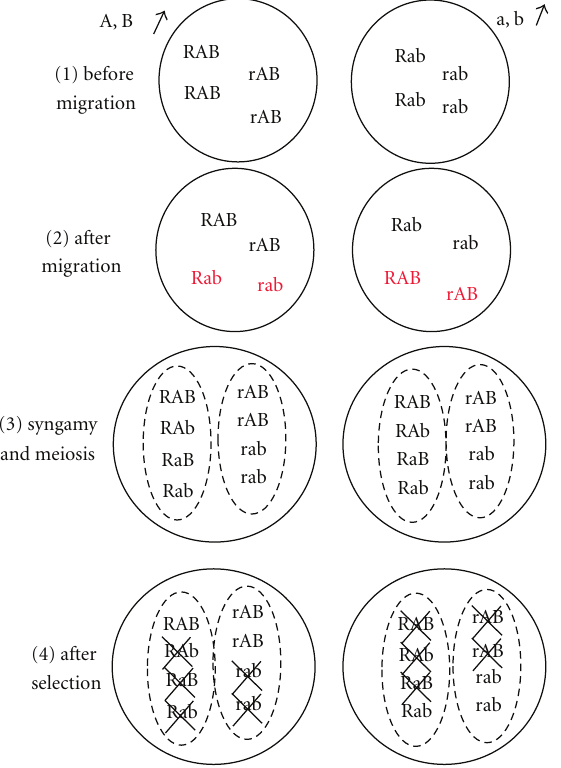
Figure 4: Indirect selection on a recombination modifier with local adaptation. Sketches how a recombination modifier evolves in presence of local adaptation (for the sake of illustration, the R allele causes maximal recombination, and the r allele specifies zero recombination). Before migration (step 1), consider two habitats with haploid individuals. On the left, the A and B alleles are favored at two di ff erent loci; the a and b alleles are favored on the right. To simplify the illustration, we consider the alleles to be fixed where they are beneficial. After migration between habitats (step (2) with m = 1/2, migrants shown in red), strong LD is generated between the selected loci: in each habitat there are AB and ab but no Ab and aB haplotypes. Then random mating and meiosis occur (step 3). In each habitat, one can distinguish the subpopulation with the full R recombination allele and the zero r recombination allele (groups of four individuals on the left and right, resp.). Within the former, LD between selected loci has been much reduced (illustrated at zero, in fact even full recombination only halves LD at each meiosis), whereas in the latter it stayed intact. Importantly, at this step the r recombination modifier becomes positively associated to the extreme AB and ab haplotypes. Note also that in each habitat, variance in fitness is greater in the subpopulation with the r allele. Finally, selection occurs (favoring A and B on the left and a and b on the right, very strongly on the illustration) and takes the r allele along because of the linkage disequilibrium generated at the previous step (the overall frequency of r has risen from 1/2 to 2/3 in the illustration). Note that the case illustrated involves positive epistasis (only the extreme genotypes AB and ab survive, on the left and right, resp.). However, the r allele is favoured even if epistasis is zero, because selection is more e ffi cient in subpopulations carrying the r allele since variance in fitness is greater in these